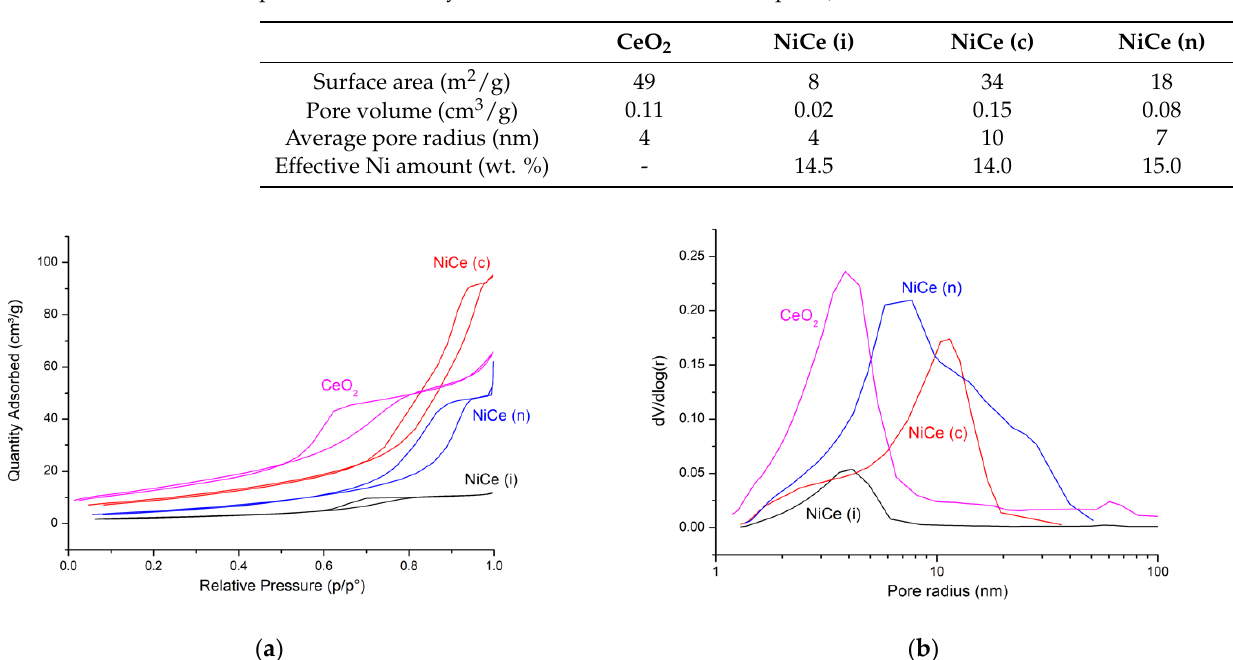
Table 1. Physical – chemical properties of Ni/CeO 2 catalysts and support (surface area calculated via B.E.T. equation; pore volume and average pore radius via B.J.H equation; real amount of nickel present in the catalysts determined via atomic adsorption).